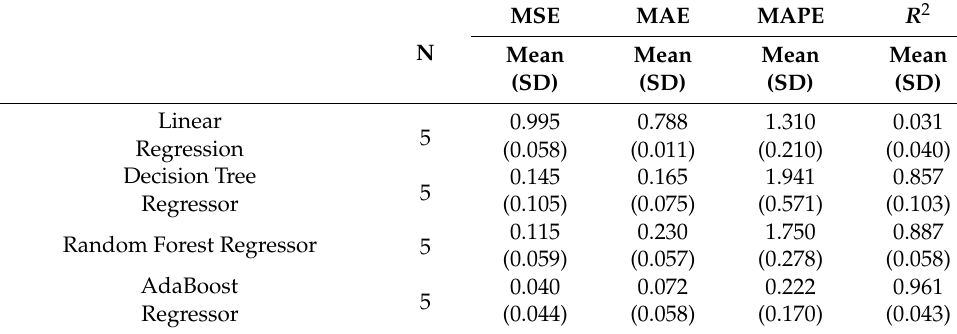
Table 9. The prediction performance of validation data of balance data.